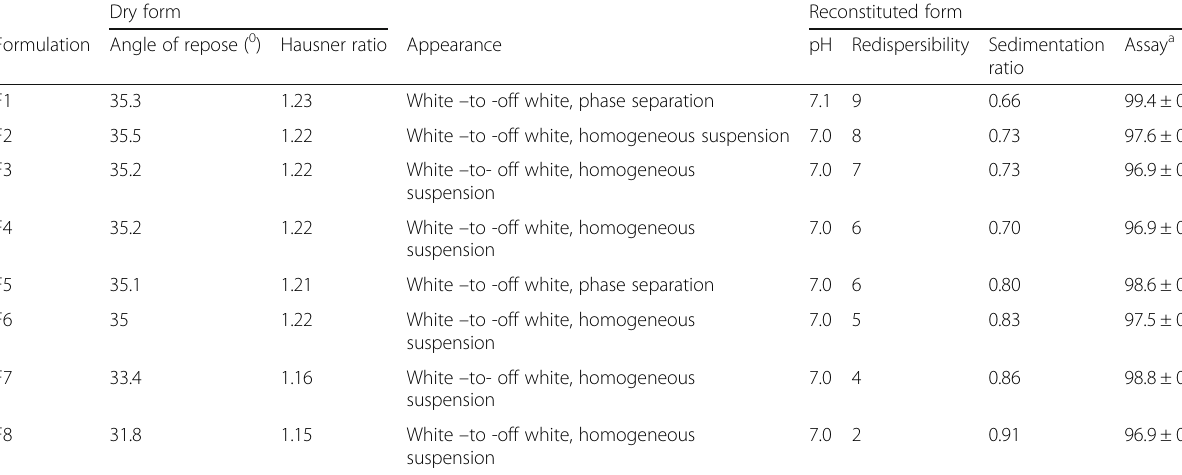
Table 4 Evaluation of dry syrup formulations of composition C3 of coated KCl Dry